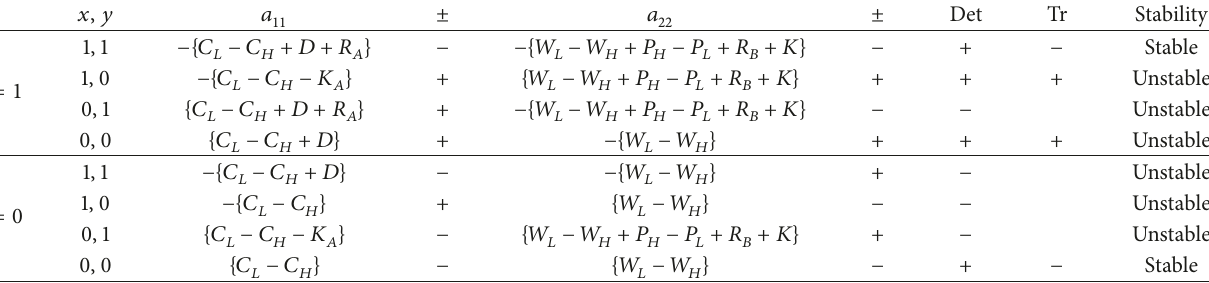
Table 3: The ESS in the first stage.